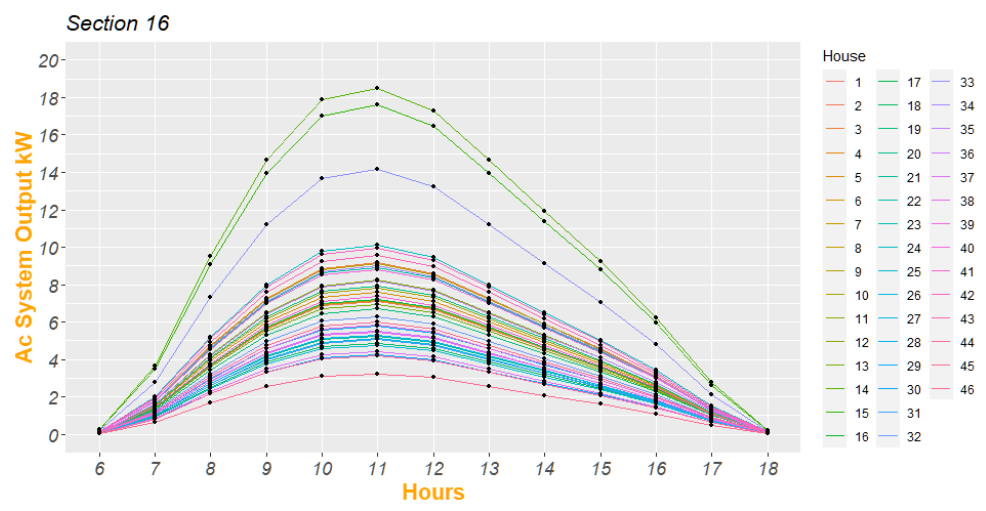
Figure 15. Average solar potential estimation in section 16 for a day.